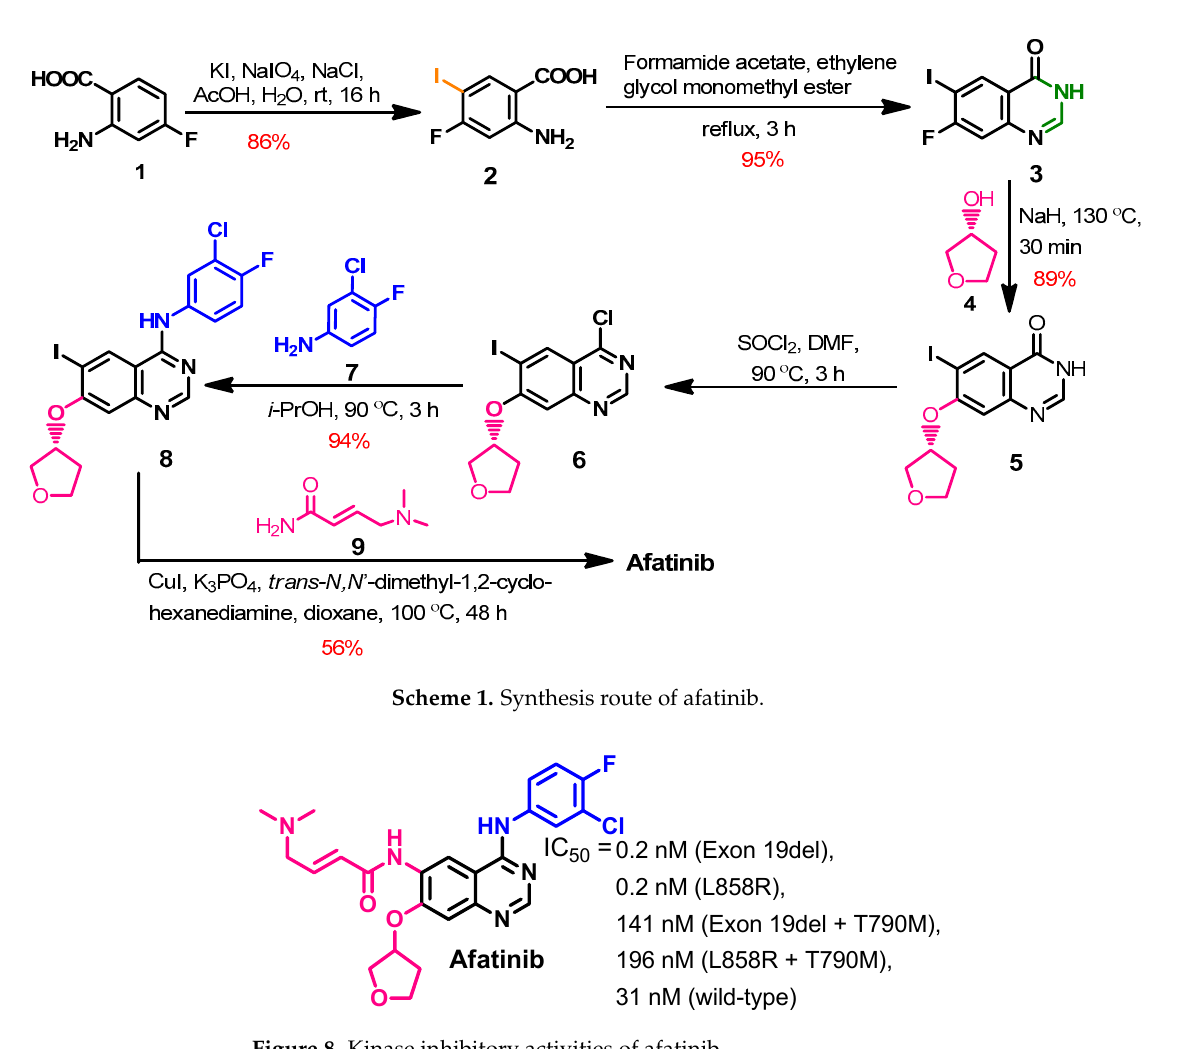
Figure 8. Kinase inhibitory activities of afatinib.